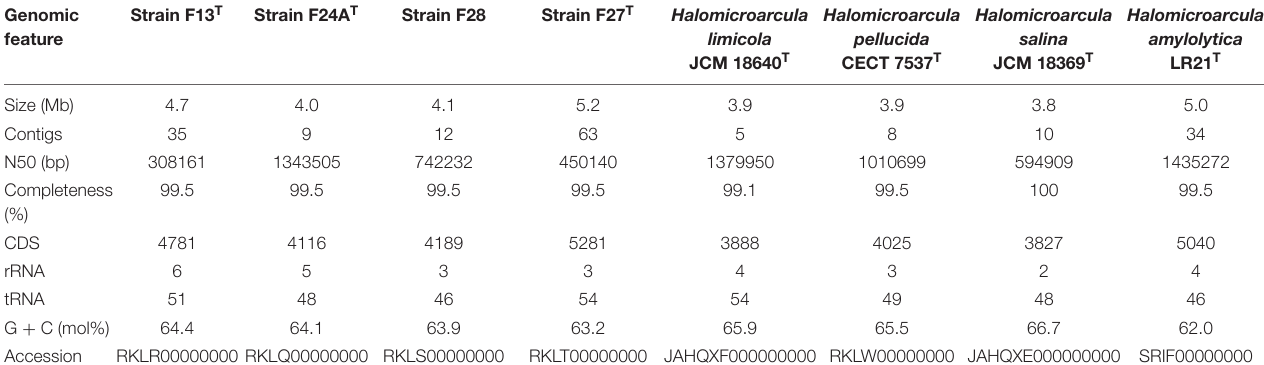
TABLE 1 | Main features of the sequenced genomes of strains F13 T , F24A T , F28, F27 T , and the type strains of species of Halomicroarcula used in this study. Genomic feature